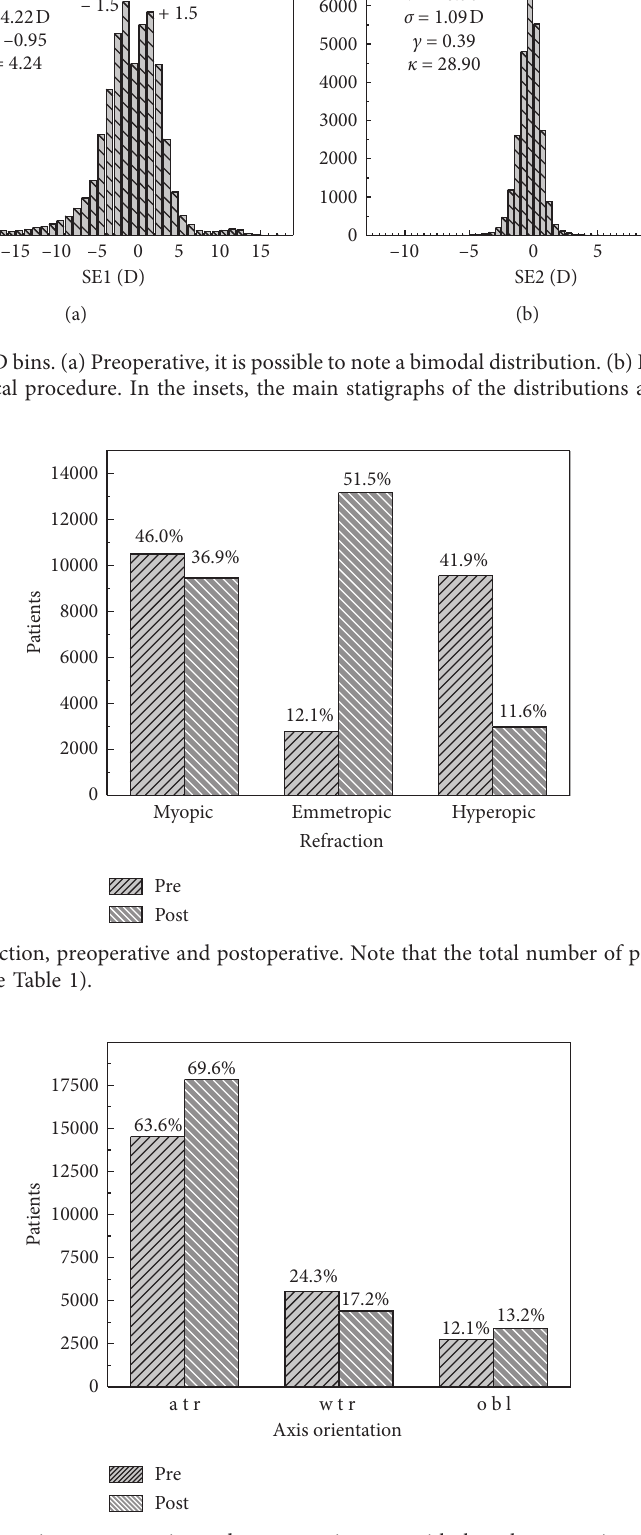
Figure 6: Proportion of type of astigmatism, preoperative and postoperative. wtr: with the rule; atr: against the rule; obl: oblique. Note that the total number of patients, preoperative and postoperative, are different (see Table 1).